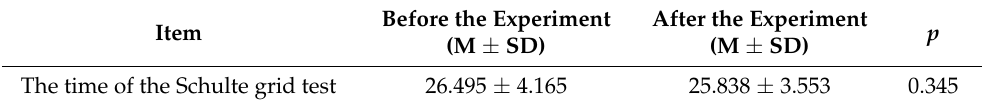
Table 6. The Schulte Grid Test results before and after the experiment in the control group. Before the Experiment After the Experiment p Item (M ± SD) (M ± SD) The time of the Schulte grid test 26.495 ± 4.165